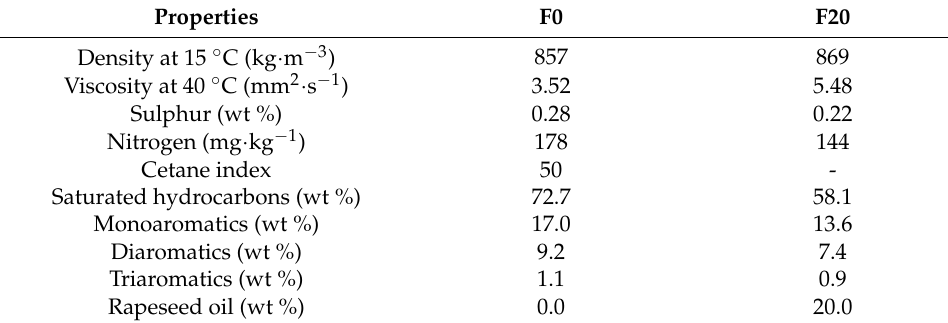
Table 11. The properties of the feedstocks for hydrotreating.